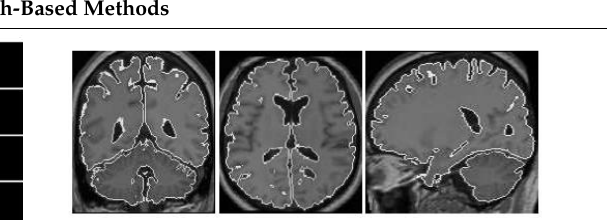
Segmentation of brain MRI with means shift: (left) Original MRI and (right) Result of segmentation; illustration reproduced with the permission from Elsevier [62].